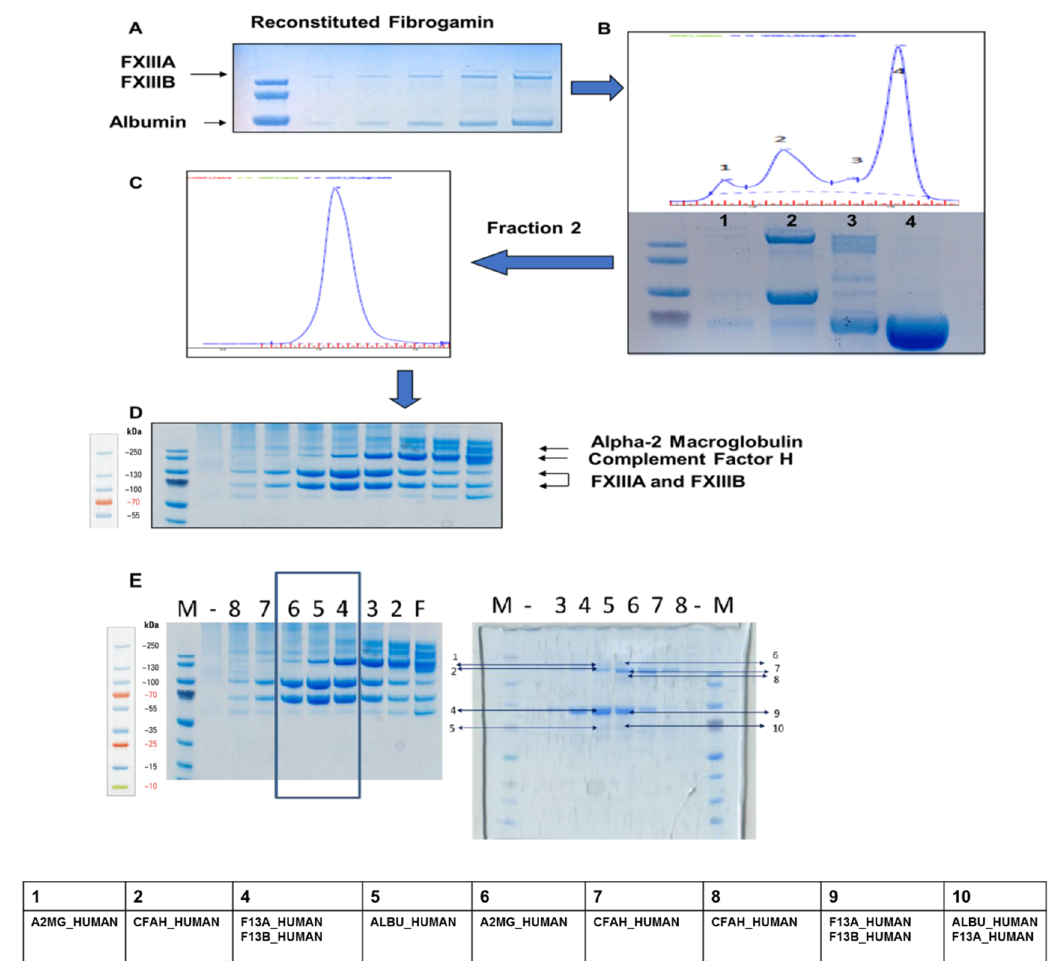
Figure 2. Plasma FXIII concentrate (FibrogamminP) analysis. ( A ) The preliminary SDS-PAGE gel run of the commercial FXIII plasma concentrate “FibrogamminP” reconstituted in water. The fastest running band corresponds to human serum albumin, which is a known constituent of FibrogamminP. ( B ) Mass based separation of reconstituted FibrogamminP run on a SEC column (Superdex 200 PC 3.2/30 column, running buffer: 20 mM Tris HCl, pH 7.4; 120 mM NaCl). The four main peaks of interests were collected separately. Peak 4 corresponds to albumin (size-wise). Peak 2 contained majority of FXIII-A 2 B 2 heterotetramer complex. The sampled Peak 2 was separately run again, but it still resolved into one peak only shown in ( C ). This single, monodispersed peak was fractioned, sampled and run on an SDS-PAGE, fraction wise as collected from the SEC; which is shown in ( D ) The separated bands (see Figure S3) were excised and evaluated with Mass spectrometry. ( E ) This panel consists of two SDS-PAGE gels, the gel 1 is same as the one in ( D ) depicting fractions corresponding to FXIII complex (boxed lanes). These three fractions were re-pooled and ran on GFC, with fractions separated on gel 2. Marked bands were analysed by mass spectrometry. The labels at the top of both gels are numbered based on fraction ids from the gel filtration runs not to be confused with lane numbers. The “F” represents the crude fraction of FibrogamminP. Table at the bottom represents the major protein hits corresponding to each band (total nine). For detailed peptide summary report please refer supplementary material (Figure S3).